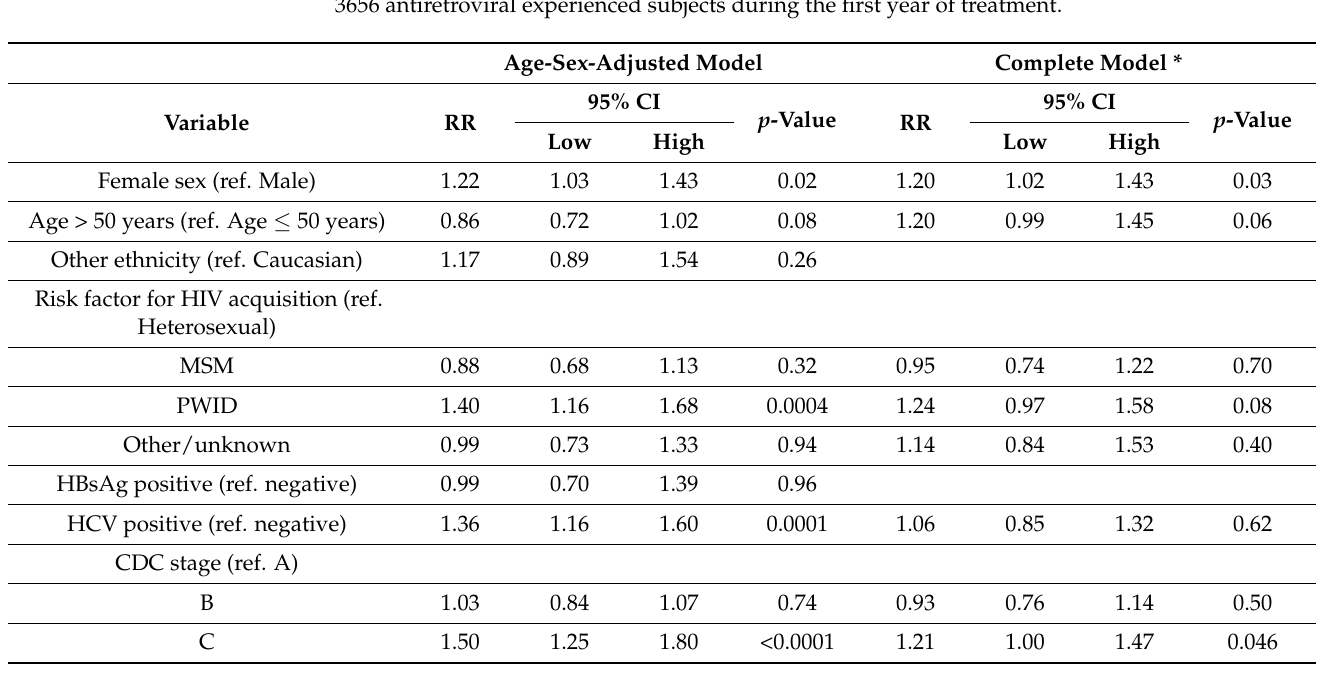
Table 3. Rate ratios (RR) and 95% confidence interval (CI) for any cause treatment interruption in 3656 antiretroviral experienced subjects during the first year of